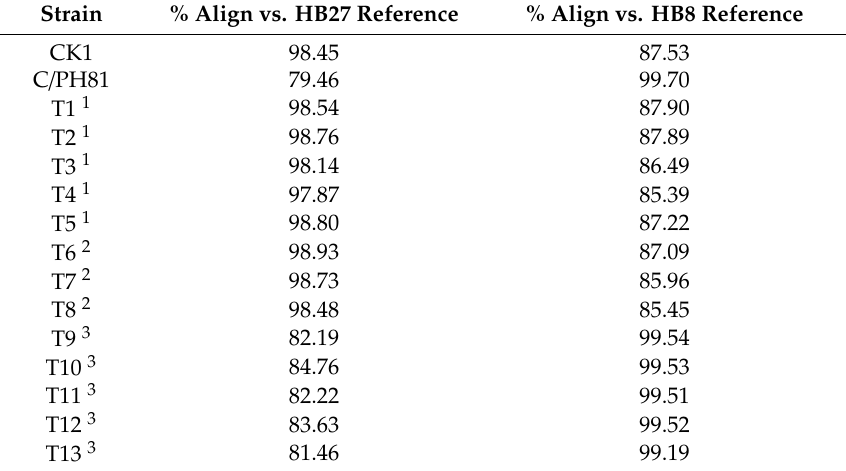
Table 2. Reads recruitment vs. reference genomes. The genomes of the T. thermophilus HB8 and HB27 strains were used as reference for the recruitment of sequences obtained for the parental strains and the transjugants in experiments between labeled wild-type HB27 and HB8 strains (T1 to T8) or between a transformation deficient HB27 and a wild-type HB8 strain (T9–T13).